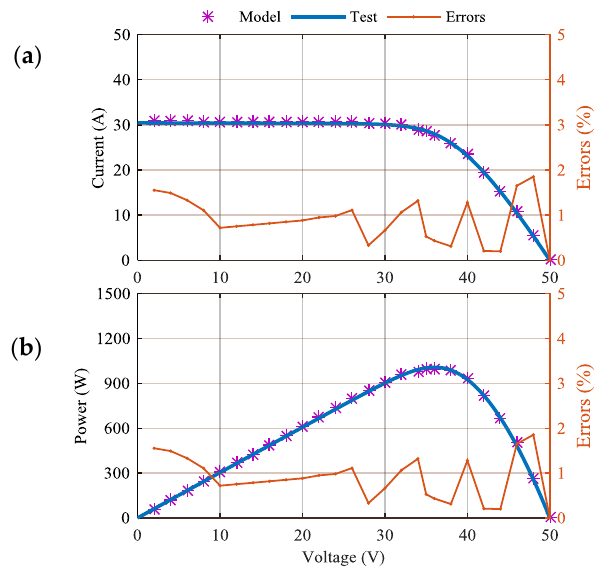
Figure 2. The comparison of photovoltaic (PV) array simulator and theoretical model. ( a ) The relationship between voltage and current; ( b ) The relationship between voltage and power.